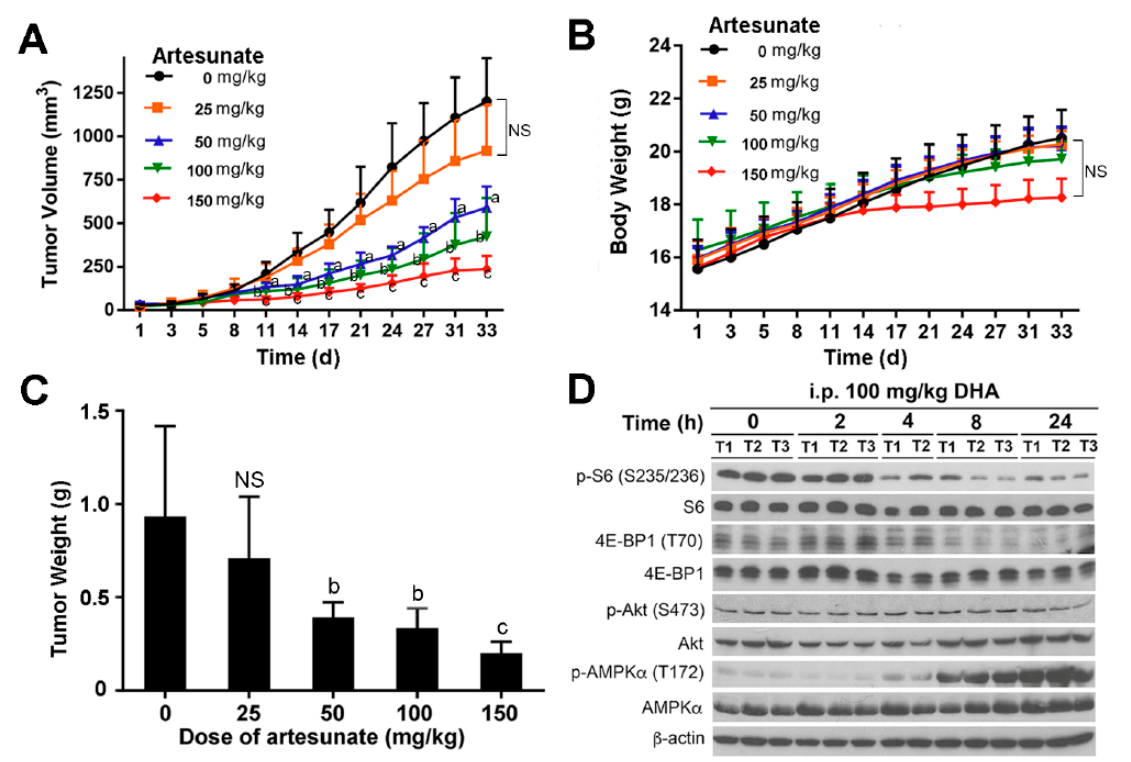
Figure 9. Artesunate inhibits tumor growth, suppresses mTORC1 and activates AMPK in RMS xenografts. ( A – C ) C.B.17SC scid − / − female mice (5–6 weeks old) bearing Rh30 xenografts were treated intraperitoneally (i.p.) with artesunate at the indicated doses or vehicle (0.9% NaCl) once daily. Tumor volume ( A ) and body weight ( C ) were measured at the indicated time. At the end of the experiment, the mice were sacrificed, and the tumor tissues were dissected and weighed ( B ). The data are expressed as the mean ± SD (8–9 mice per group). NS, not significant; a p < 0.05; b p < 0.05; c p < 0.001, difference with the control group (0 mg/kg of artesunate). ( D ) C.B.17SC scid − / − female mice (5–6 weeks old) bearing Rh65 xenografts were treated i.p. with DHA (100 mg/kg). After the treatment for the indicated time, the mice were sacrificed, and the tumor tissues were collected and frozen in liquid N 2 . Western blotting was performed with indicated antibodies. Control means non-treatment with DHA; T1, T2, and T3 represent tumors #1, #2, and #3, respectively.